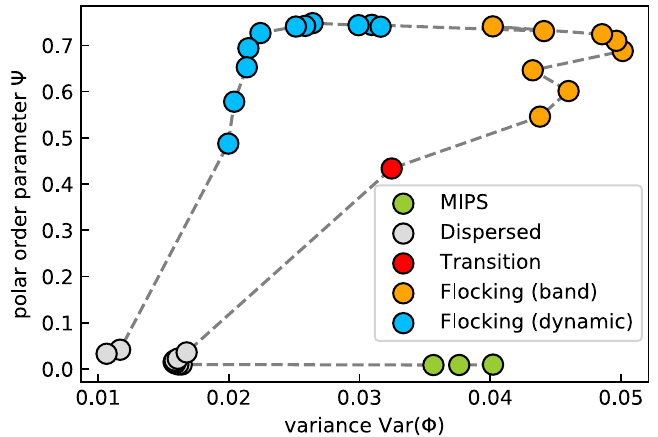
Figure 6. Polar order parameter (cid:31) versus variance Var (φ) of the density distributions for all values of T 0 1.18 . The dashed line connects points with increasing value T 0 indicated in Fig. 2 with interaction range R /σ = starting from the MIPS